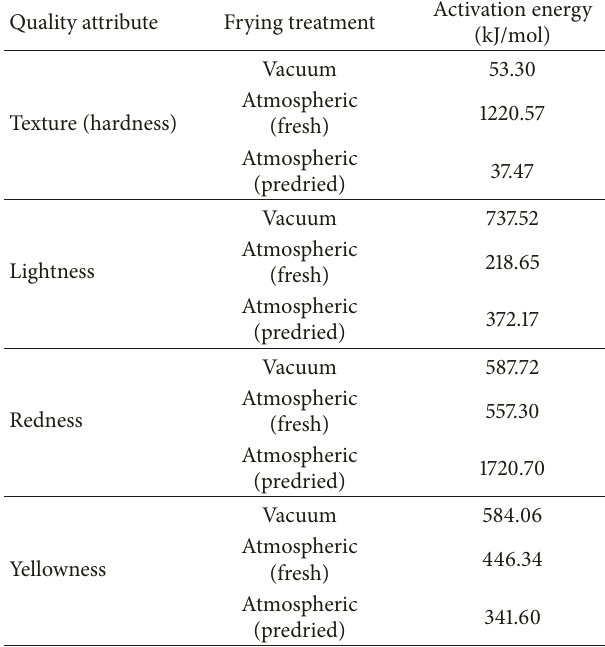
Table 3: Activation energies for different frying experiments. Quality